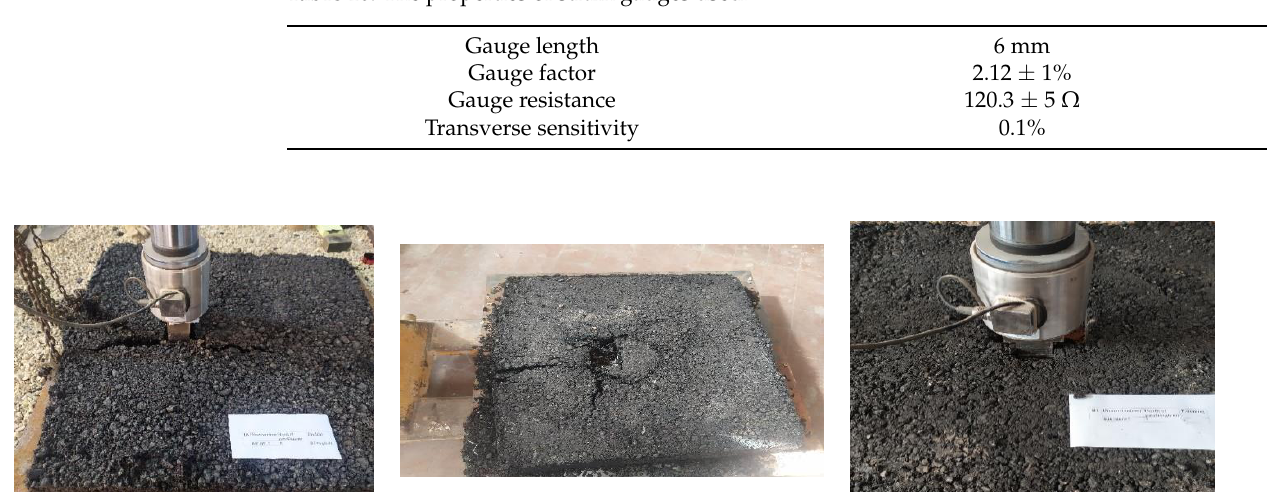
Table 10. The properties of strain gauges used.